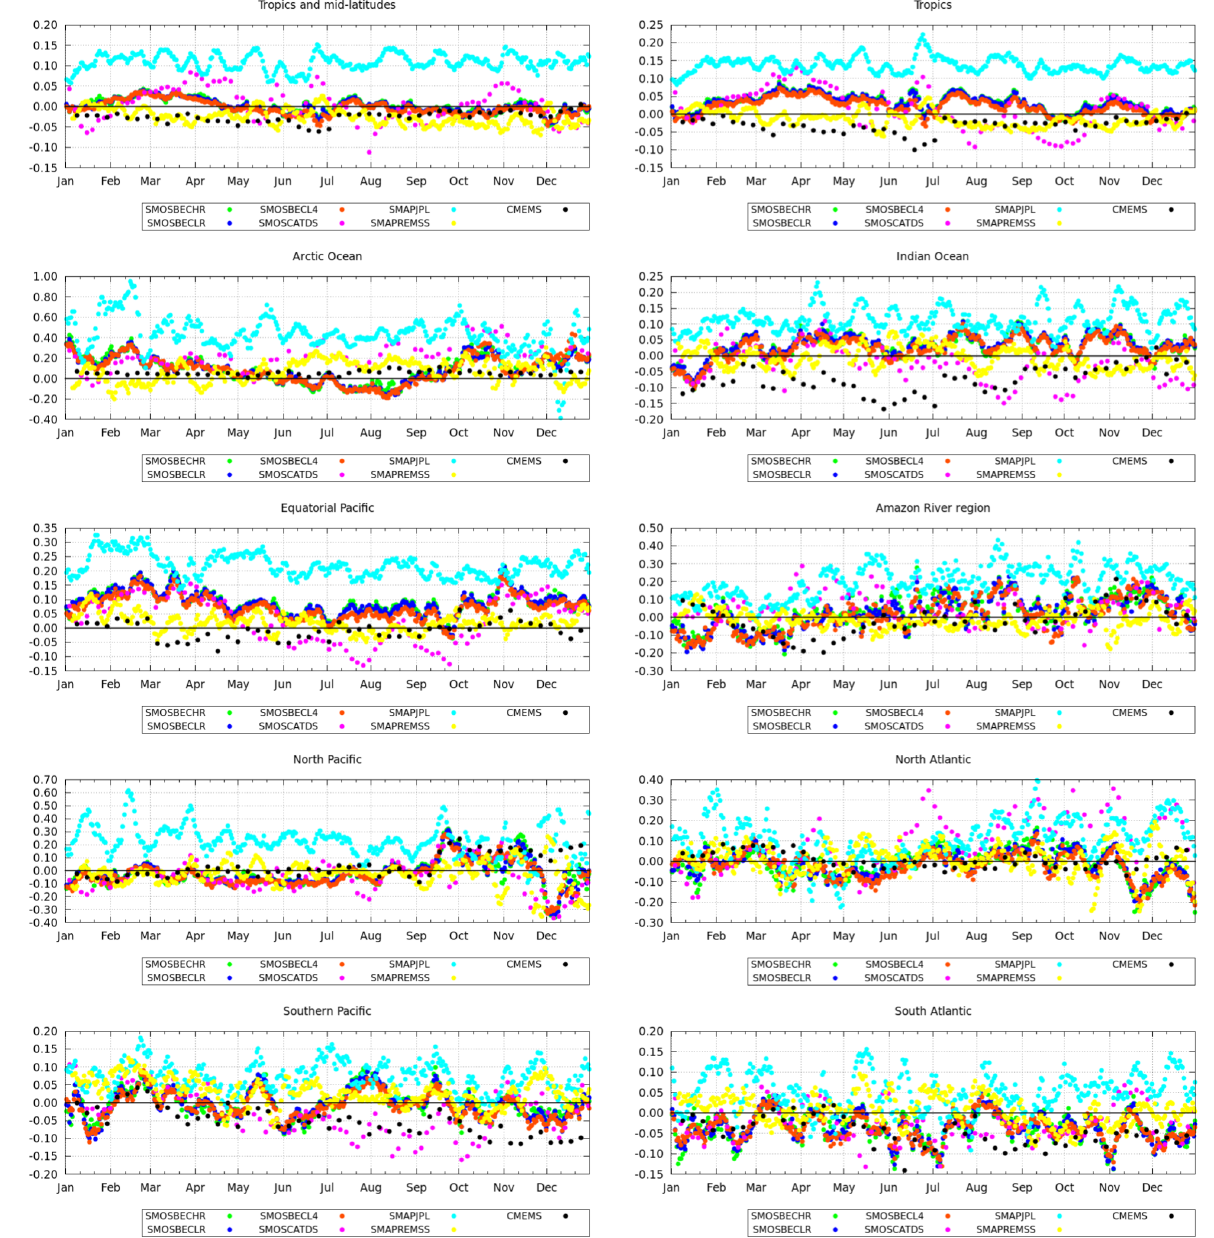
Figure 10. Mean of the differences between the gridded SSS products and Argo salinity in different ocean regions for the year 2017.